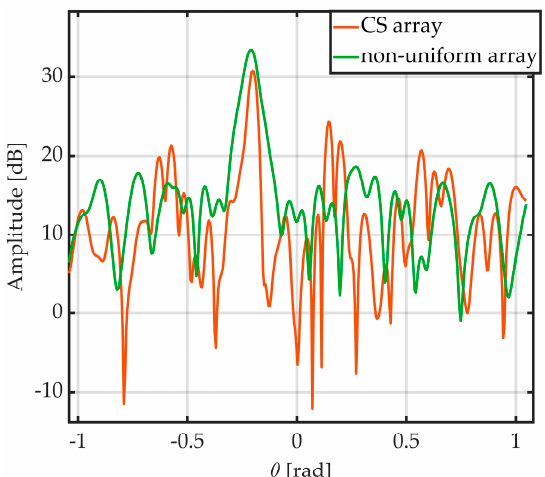
on the y-z plane that intersects the corner reflector position.